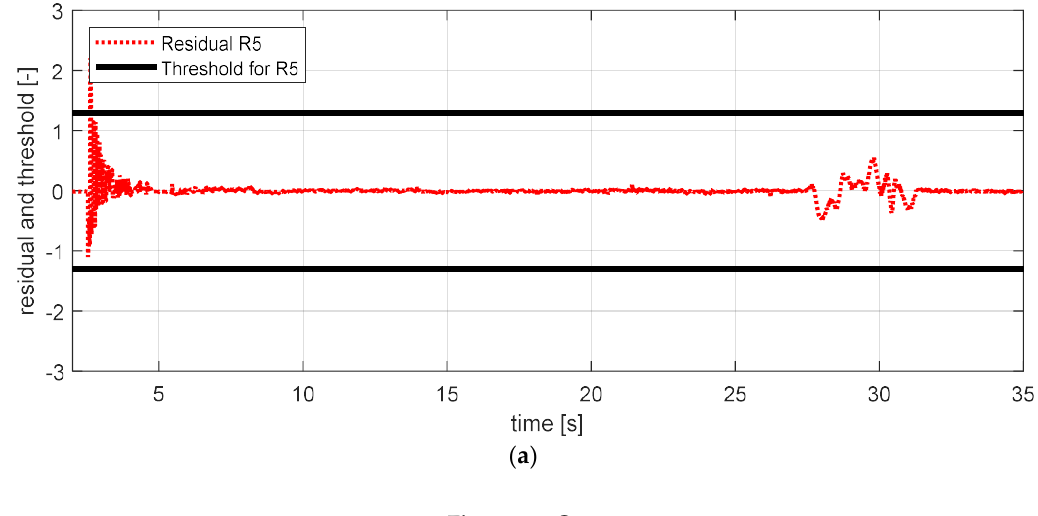
Figure 26. FDI simulation result for wheel angular speed sensor—rr (fault). ( a ) Residual 4 and threshold; ( b ) residual 5 and threshold.